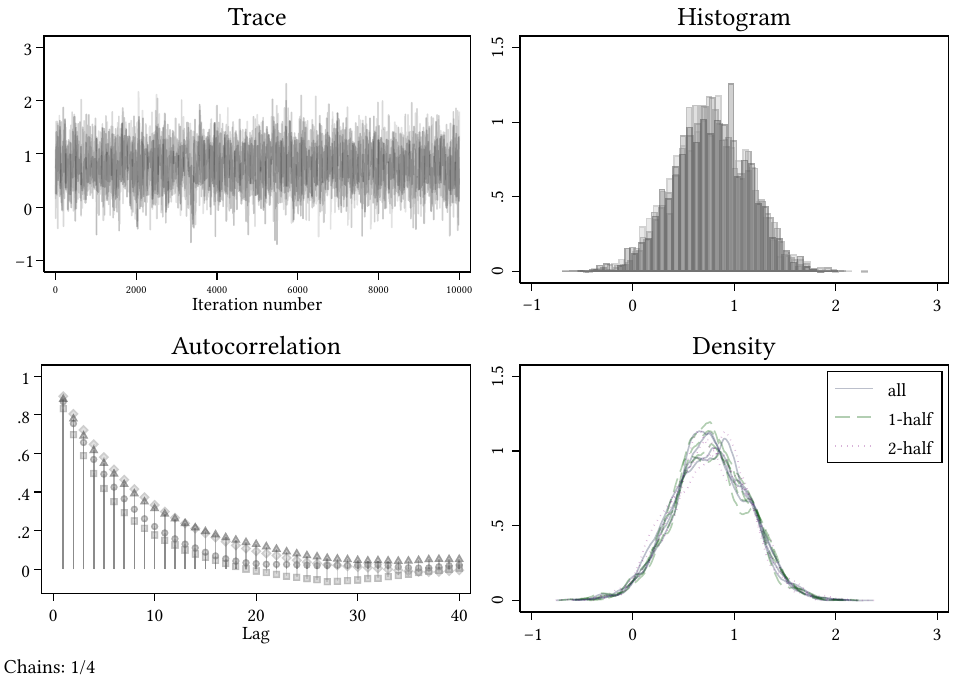
Figure A4. How awareness of the price effect influences the response to extreme asks. The Low Info